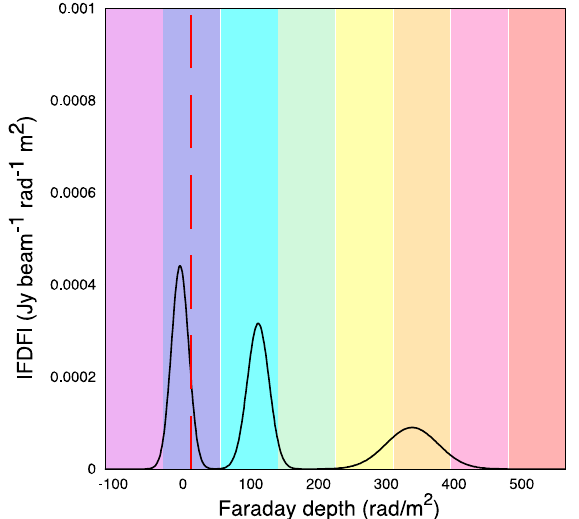
Figure 2. The example plot of the best-fit model. Black-solid lines are model functions. A red-dashed line shows the foreground RM value of 15 rad m − 2 [11]. Colored bands are used to simplify our discussion. The widths are 85 rad m − 2 , and the center of the blue band corresponds to the foreground RM value of 15 rad m − 2 .